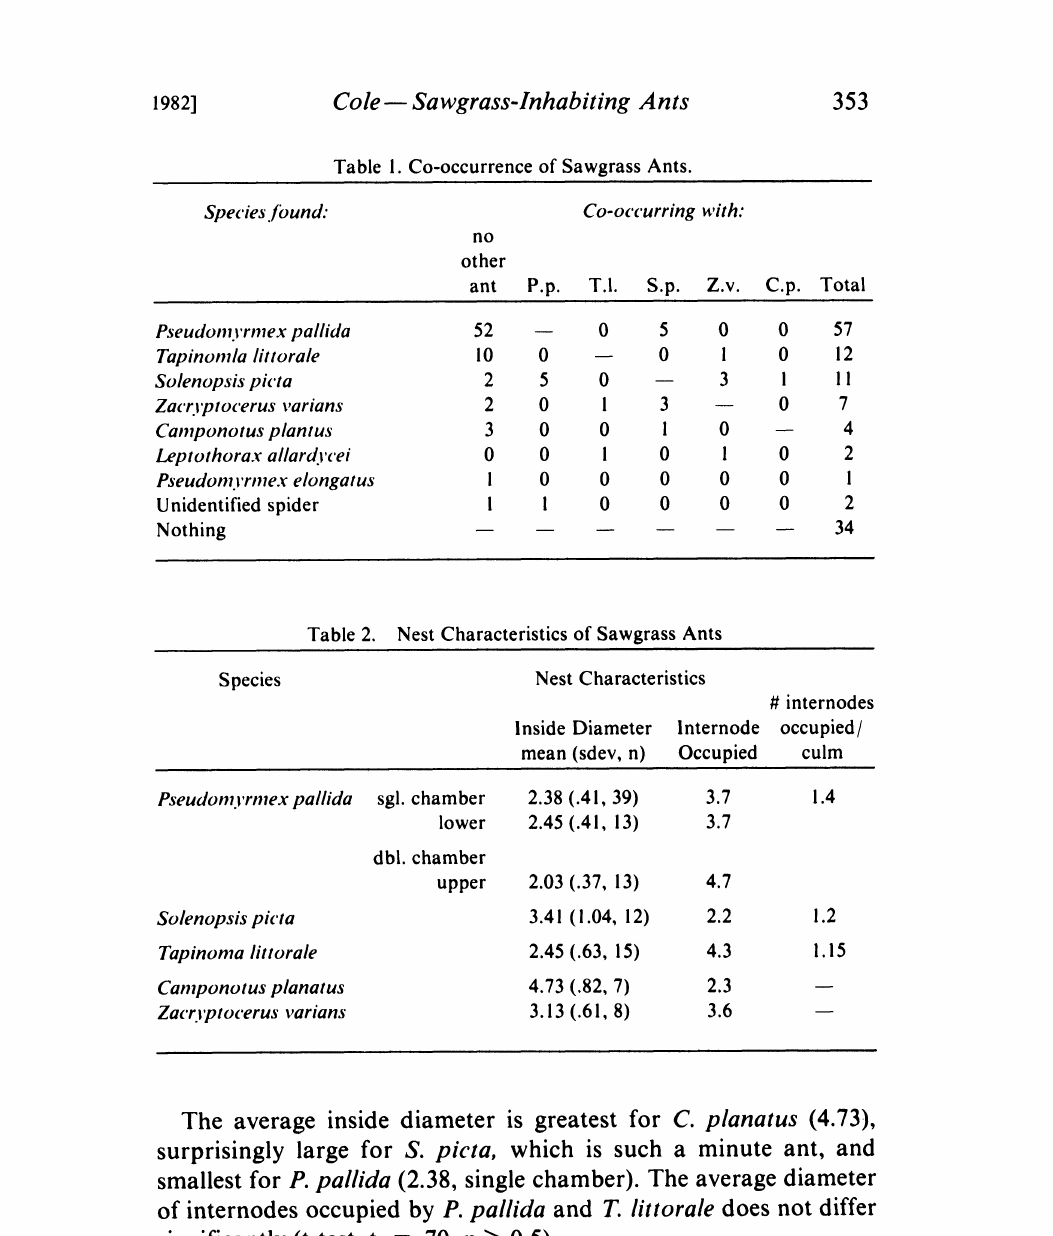
Table 1. Co-occurrence of Sawgrass Ants.